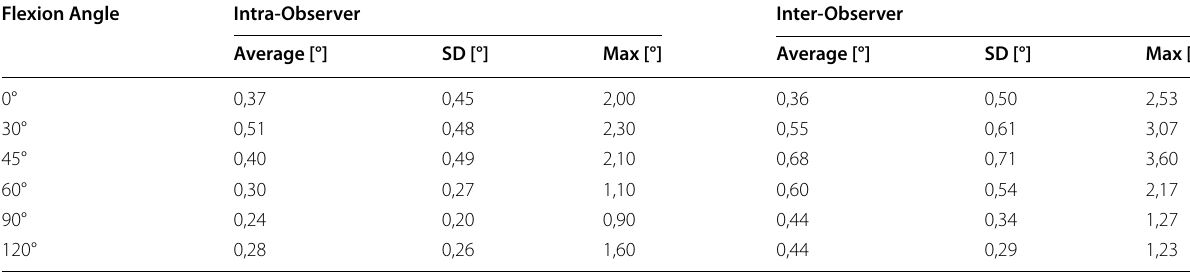
Table 3 Intra-observer and inter-observer variability for HKAa measurements Flexion